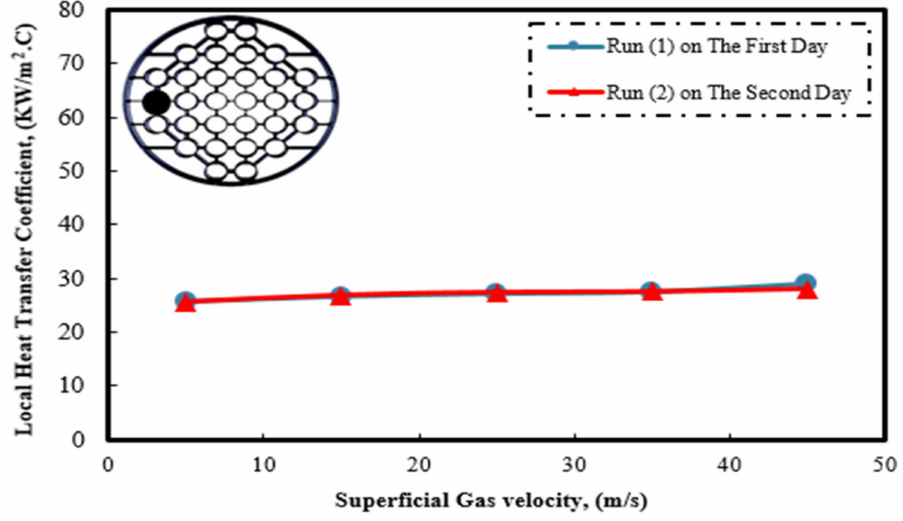
Figure 4. Reproducibility of LHTC data measured in the wall region of the studied bubble